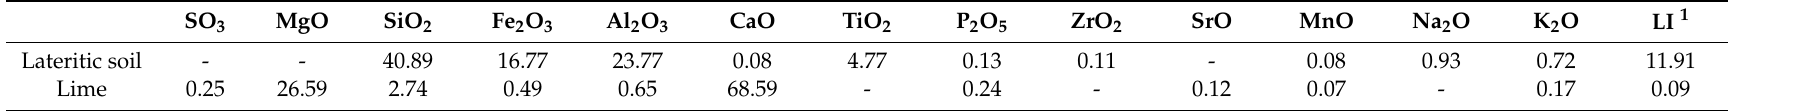
Table 2. Chemical composition of the experimental materials (values in